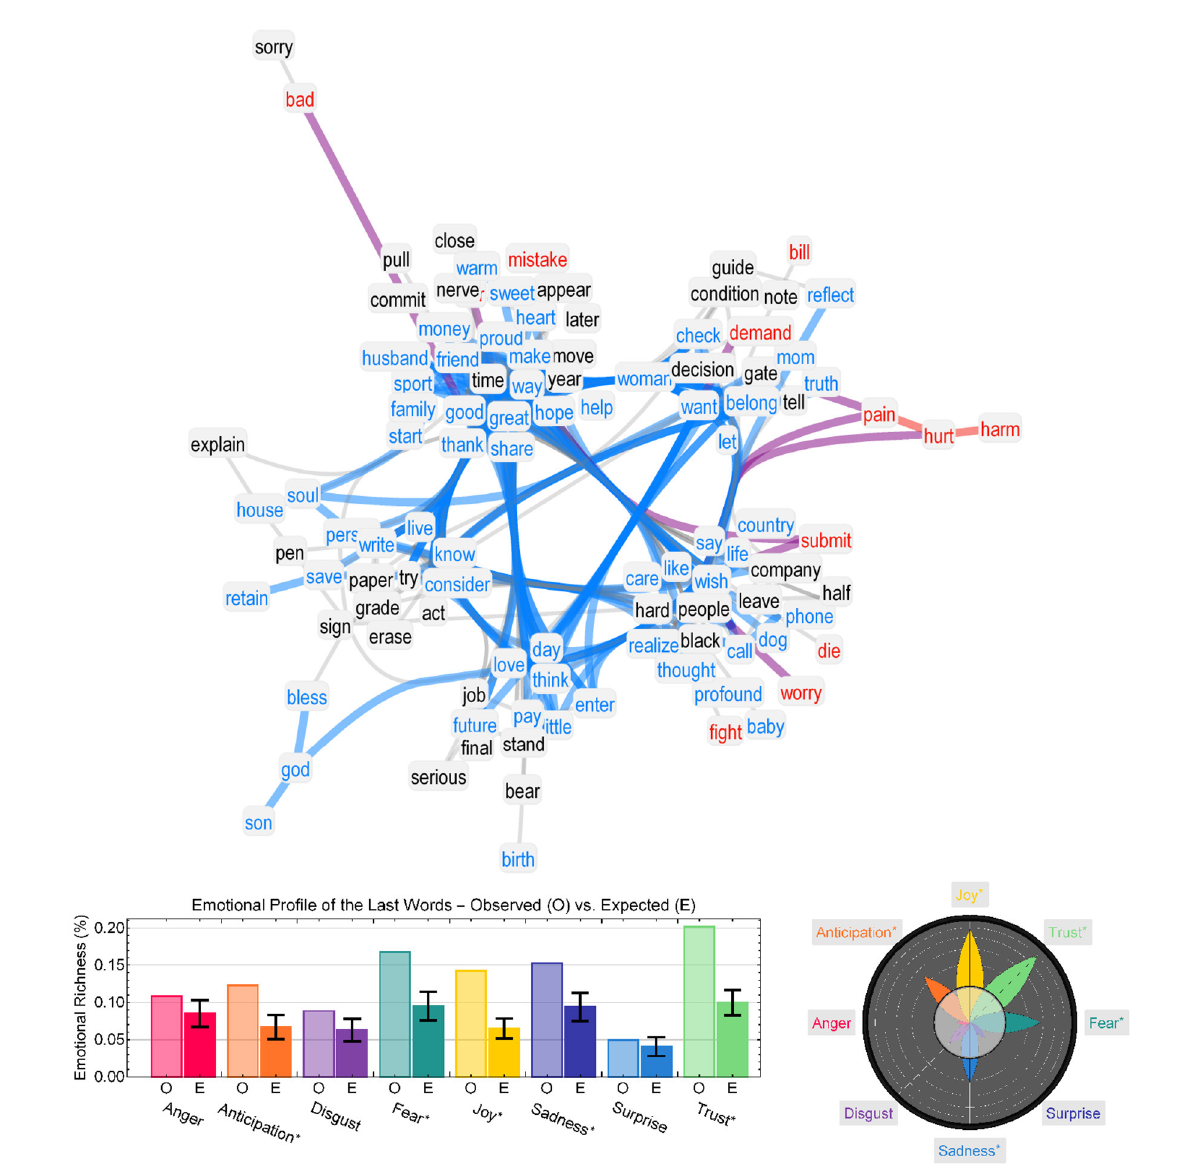
FIGURE2 Network visualization of the largest connected component of co-occurrences between last words as expressed in the suicide notes. Cyan highlights positively perceived words whereas red highlights negative concepts. Links between positive (negative) concepts are in cyan (red). Co-occurrences between positive and negative (neutral) concepts are in purple (gray). Co-occurrences between neutral words are thinner for visualization purposes. Neutral words are in black. (Left) Emotional profiles of last words observed in suicide notes against the expected profile of 1,000 random samples of 204 non-last words. (Right) Emotional flower reporting positive z-scores between the observed emotional profiles of last words and random expectation of non-last